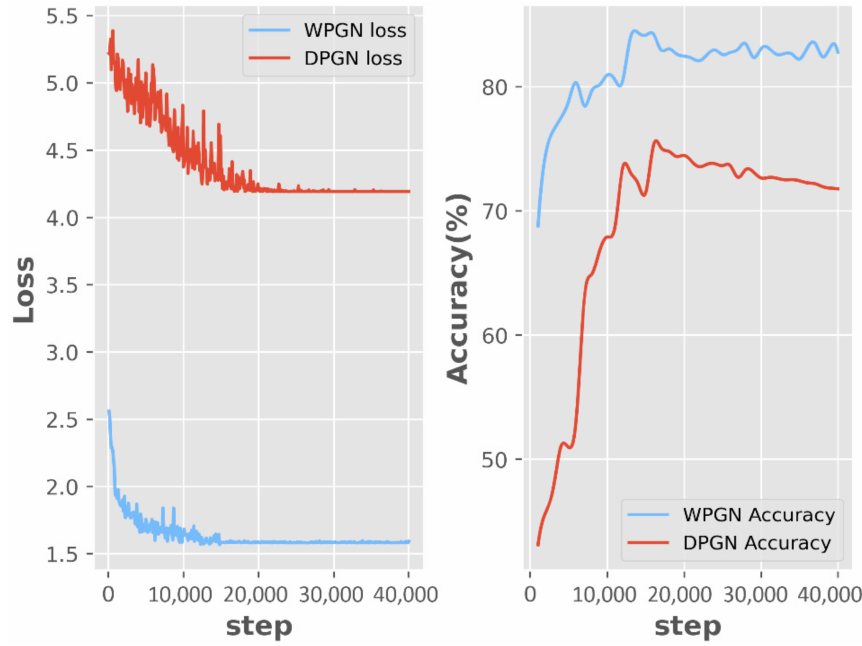
Figure 10. Training loss and test accuracy comparison. Table 9. Ablation experiment on CUB-200-2011 and